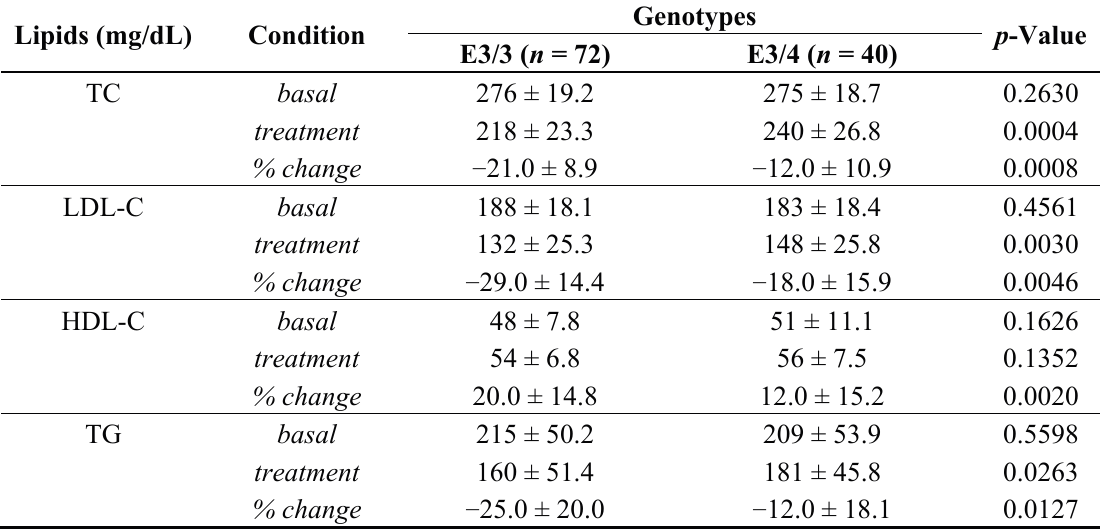
Table 4. Lipid profile and response to atorvastatin treatment (10 mg/day/4 weeks) according